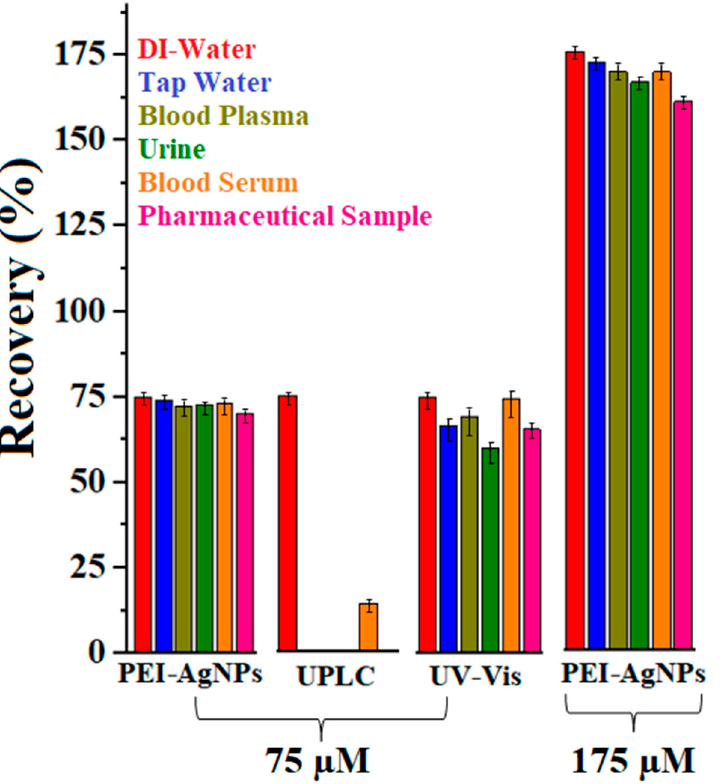
Figure 8. Quantitative performance of PEI-AgNPs based colorimetric sensing method for CIP compared to UV-Vis spectrophotometry and UPLC-based methods in tap water, blood serum, blood plasma, urine, and commercial pharmaceutical sample with reference to their response in DI water. Table 1. Comparison of the analytical methods for the determination of